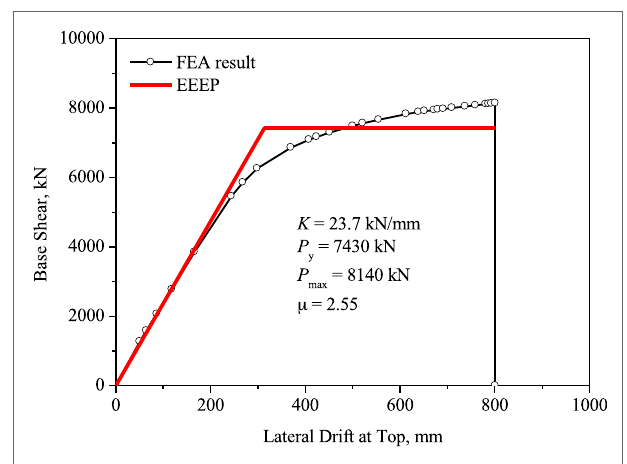
FigUre 8 | Plot of base shear vs top storey lateral drift of CHECK building based on FE analysis, and idealized bilinear response using the EEEP